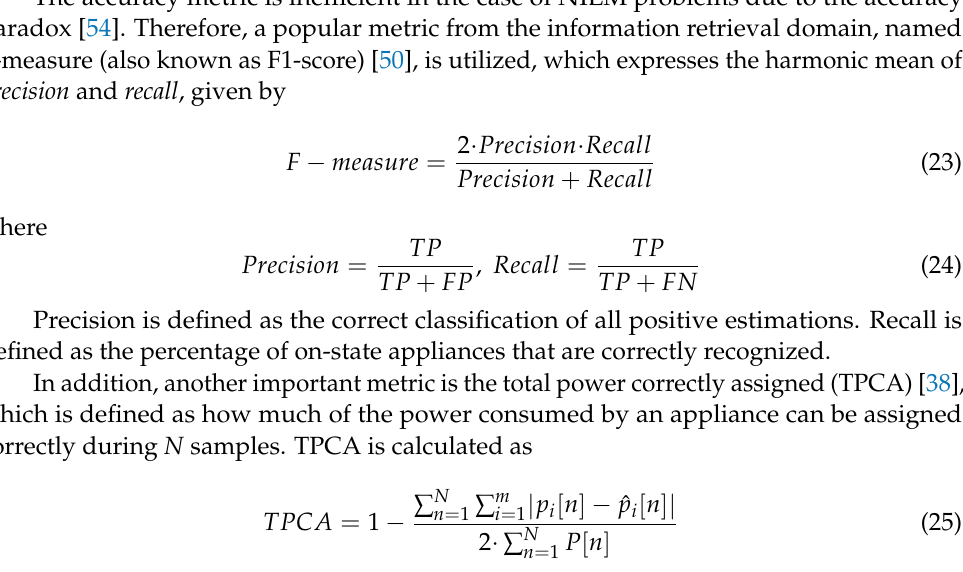
Table 5. Comparison to MCE and CO Methods with PCA Technique.